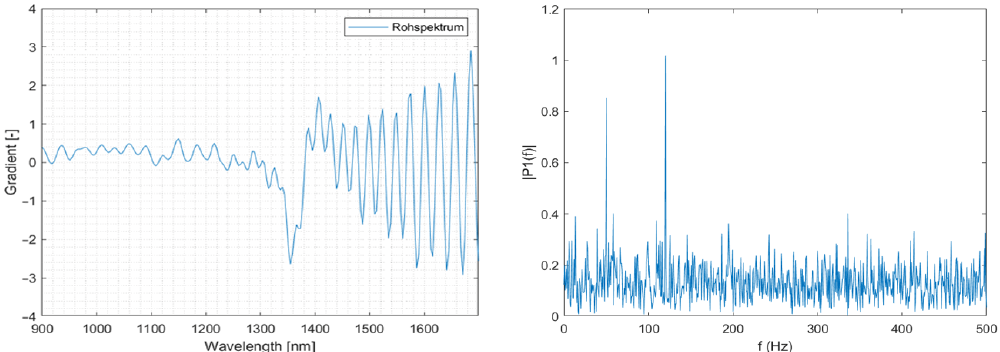
Figure 8. Spectral and Fourier depiction of a noisy signal.